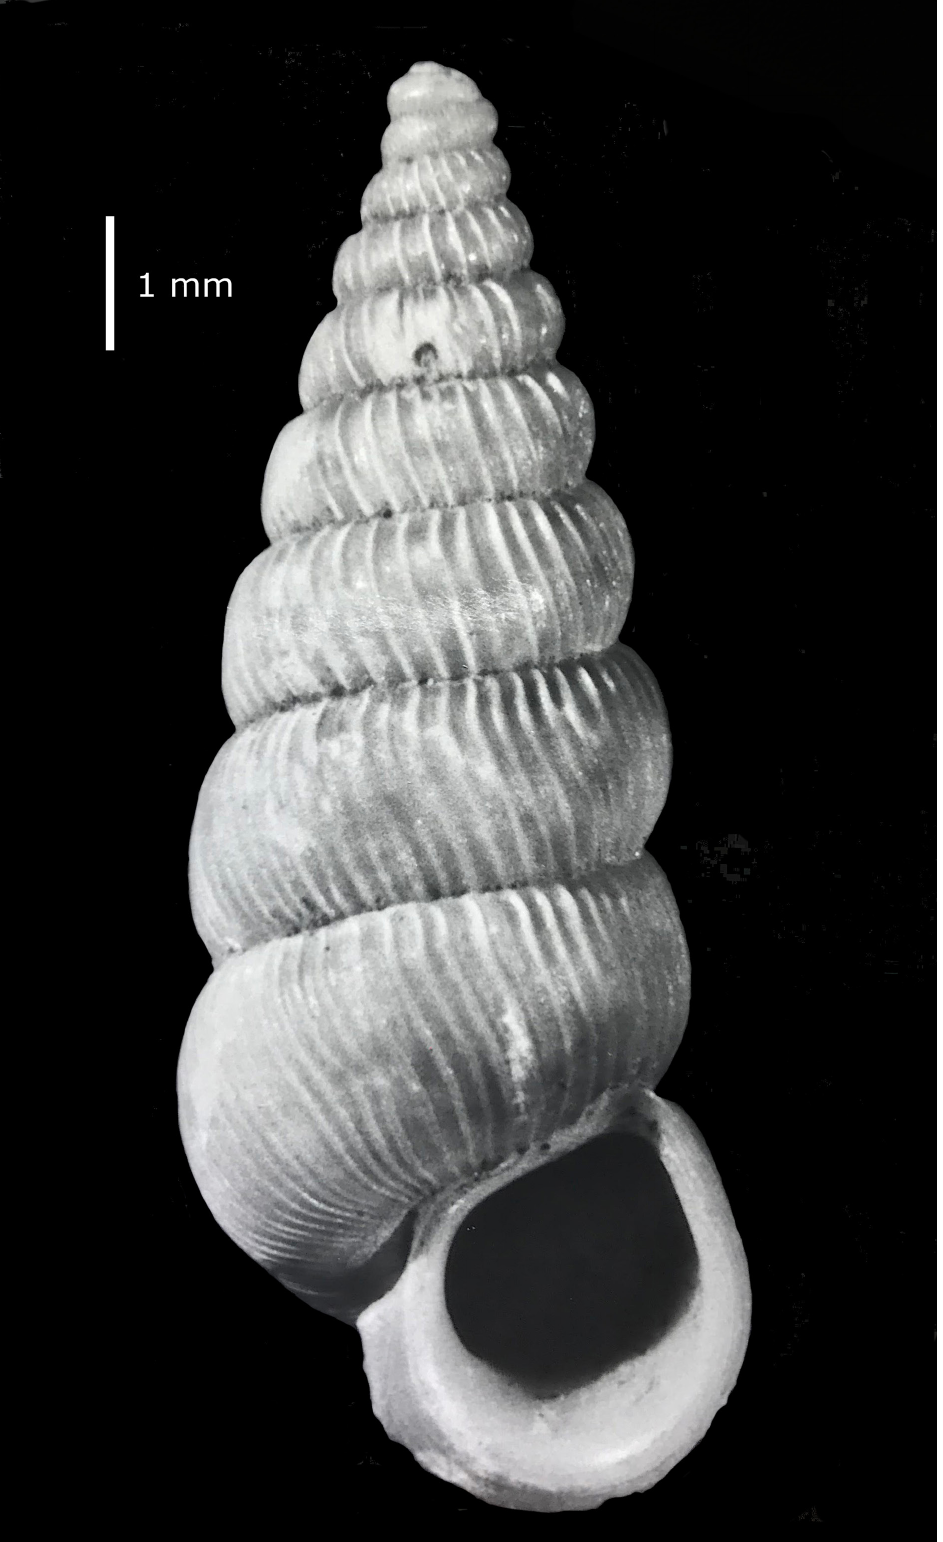
Fig. 21. Shell of Cochlostoma ( Clessiniella ) villae (Strobel, 1851). Collezione De Betta, Museo di Storia Naturale di Verona (photo Folco